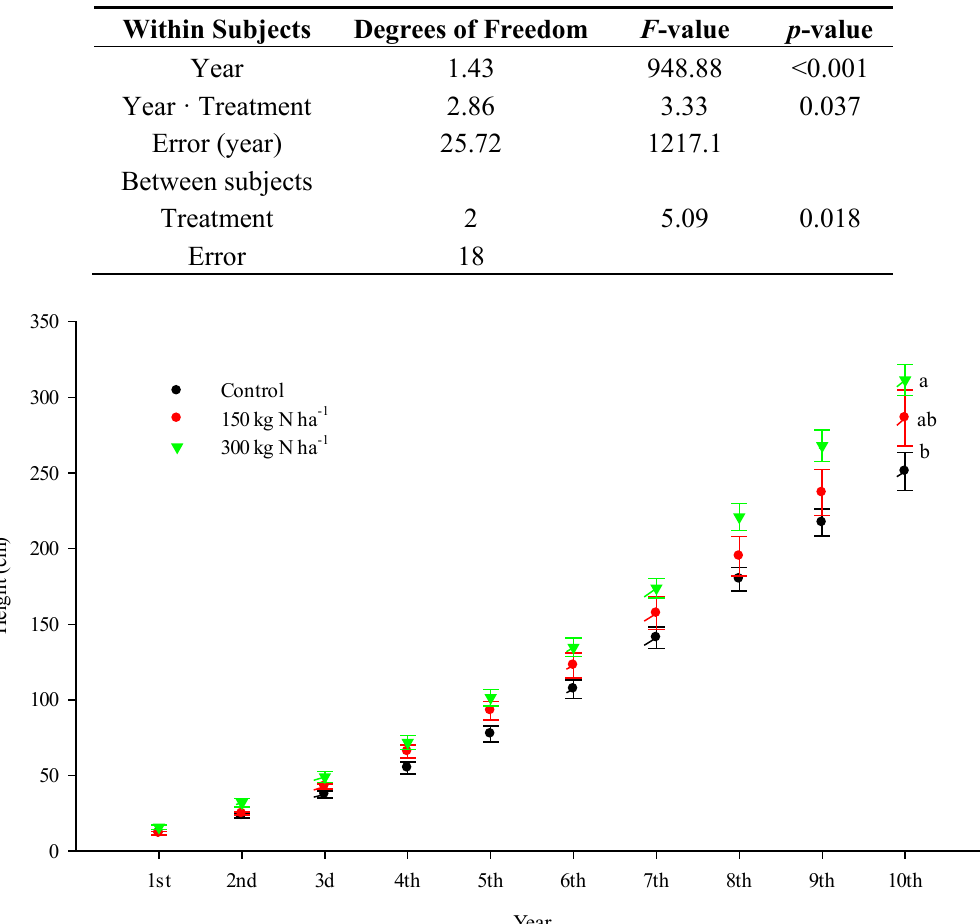
Table 2. Results from repeated measures ANOVA testing the effects of fertilization of the previous stand rotation on annual tree shoot height growth of the current stand rotation.